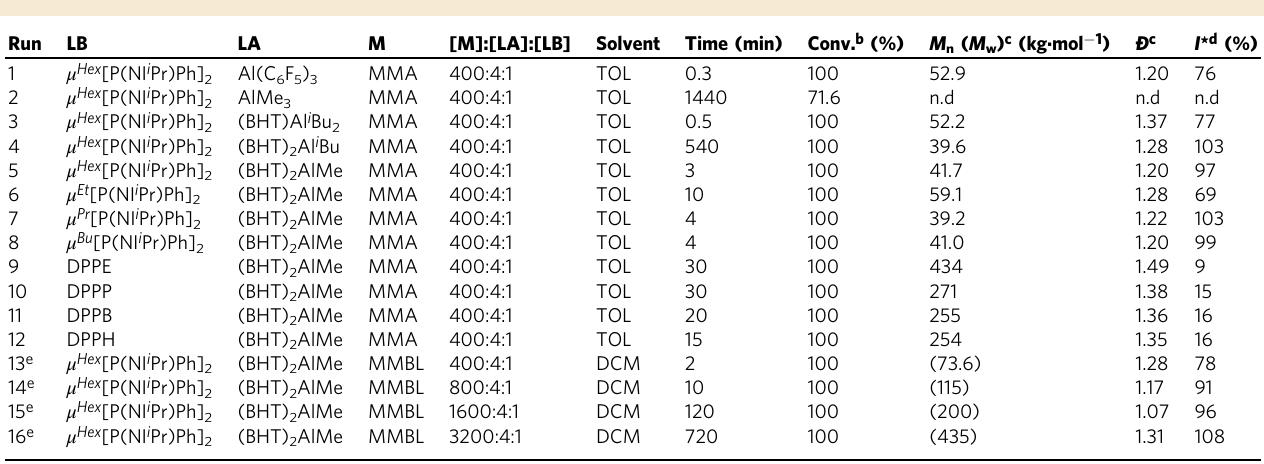
Table 1 Polymerization results by different LPs a